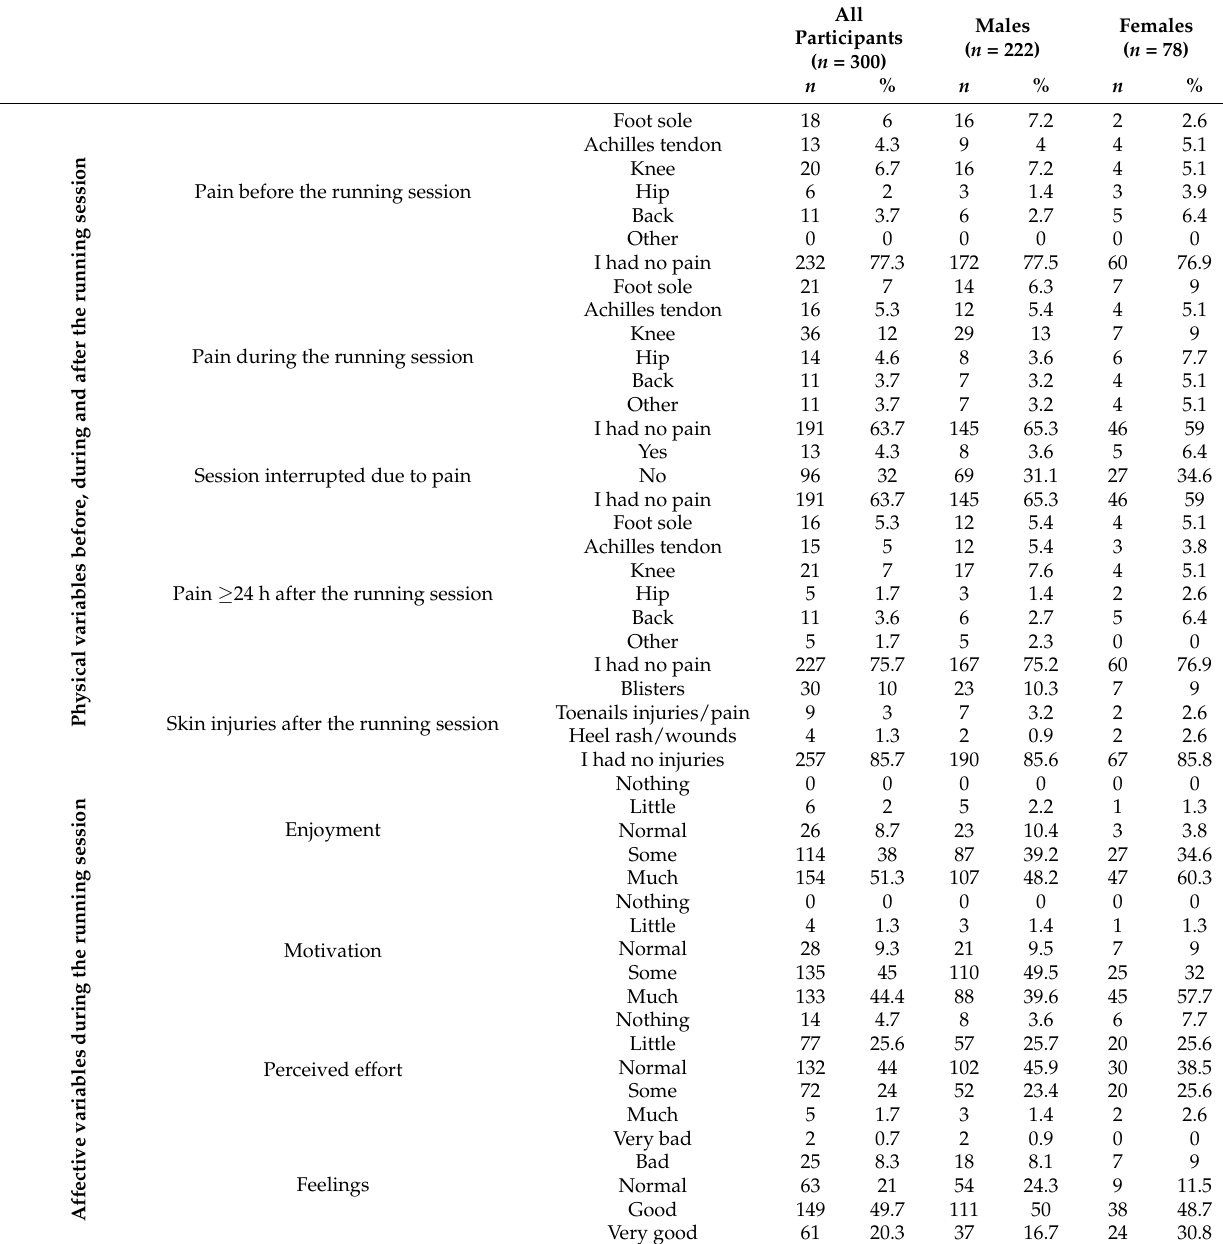
Table 4. Effects on self-perceived variables before, during and after the first outdoor running session after the 48-day home quarantine of recreational runners in